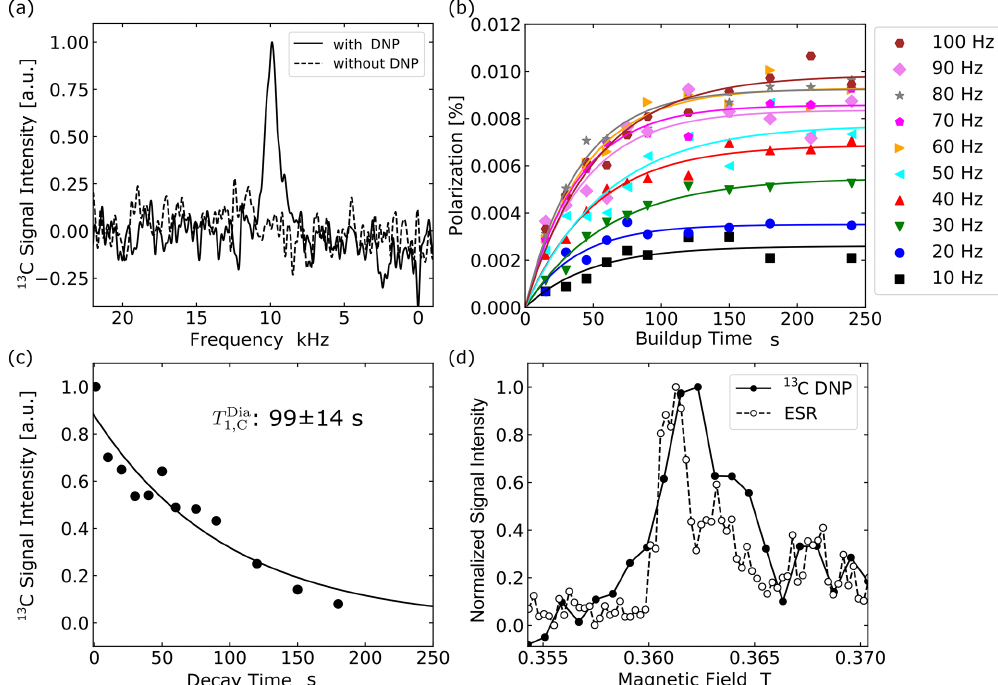
Figure 5. Optical hyperpolarization in microdiamonds. (a) NMR spectra of 13 C in microdiamonds averaged over four times. The solid line shows the 13 C NMR signals with DNP and the broken line shows that without DNP. The spectrum was obtained with a laser repetition frequency of 100Hz and 240s of DNP buildup time. (b) Buildup curves of 13 C polarization in microdiamonds obtained with ISE repetition rates ranging from 10 to 100Hz. (c) The relaxation curve for the 13 C NMR signal of microdiamonds. (d) The DNP and EPR field profile around